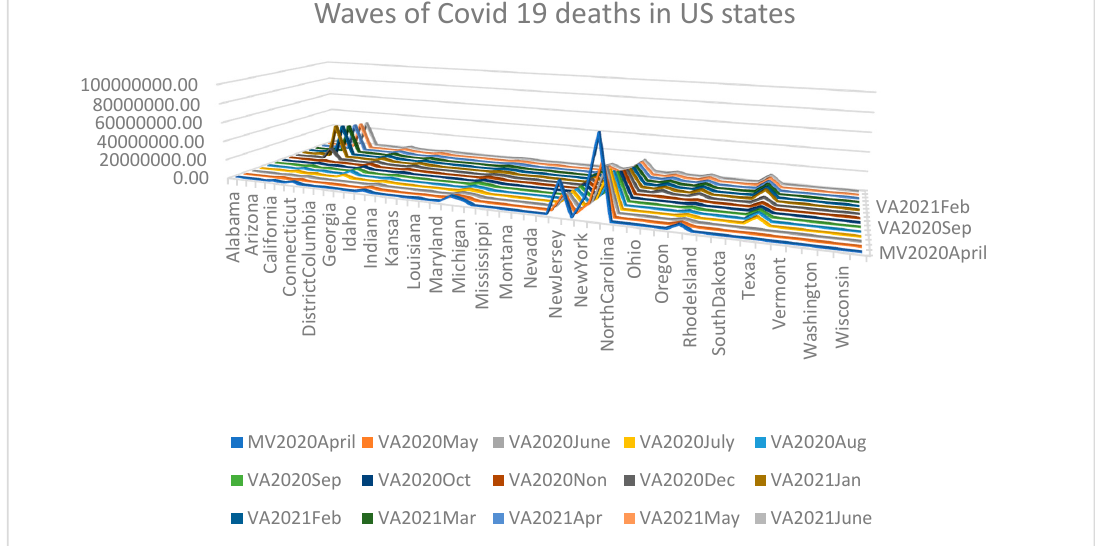
Figure 3. Pandemic waves of COVID-19 deaths in US. Table 1. Estimate of the death rate ˆ θ , restriction rate ˆ γ , hyper parameter ˆ φ , balance factor, # days n , average # deaths y , posterior mean, posterior variance, and vulnerability to death. For readability, note that 2/1/2020 refers 1 February 2020.